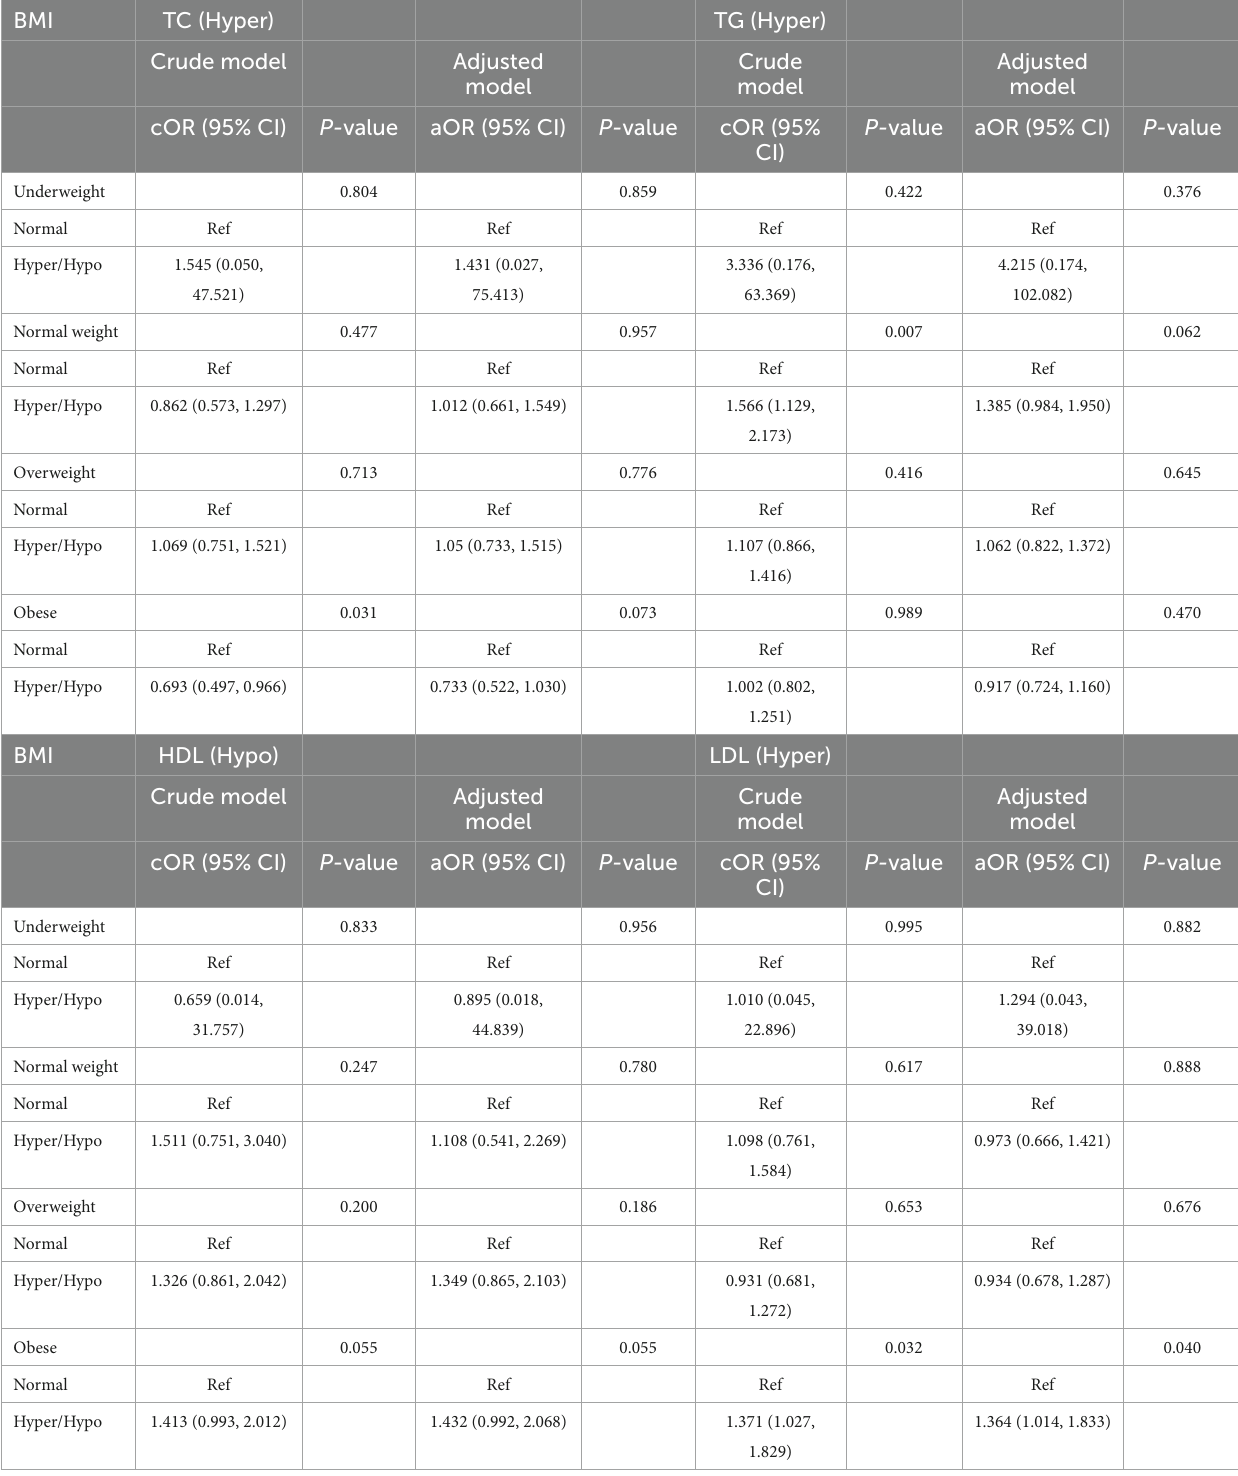
TABLE 6 Odds ratios for associations between triglyceride and cholesterol levels and anti-HBs results stratified by